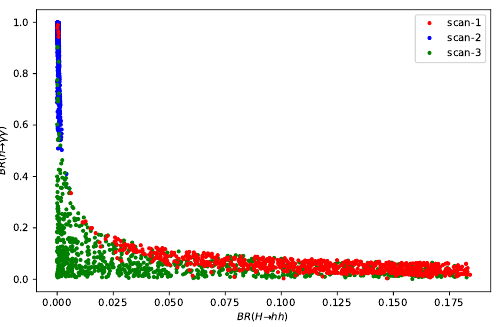
Figure 6. The correlation between BR( h ! (cid:13)(cid:13) ) and BR( H ! hh ) in the three scans. BR( h ! Z (cid:3) A ), BR( A ! (cid:13)(cid:13) ) and the four photons cross section (cid:27)